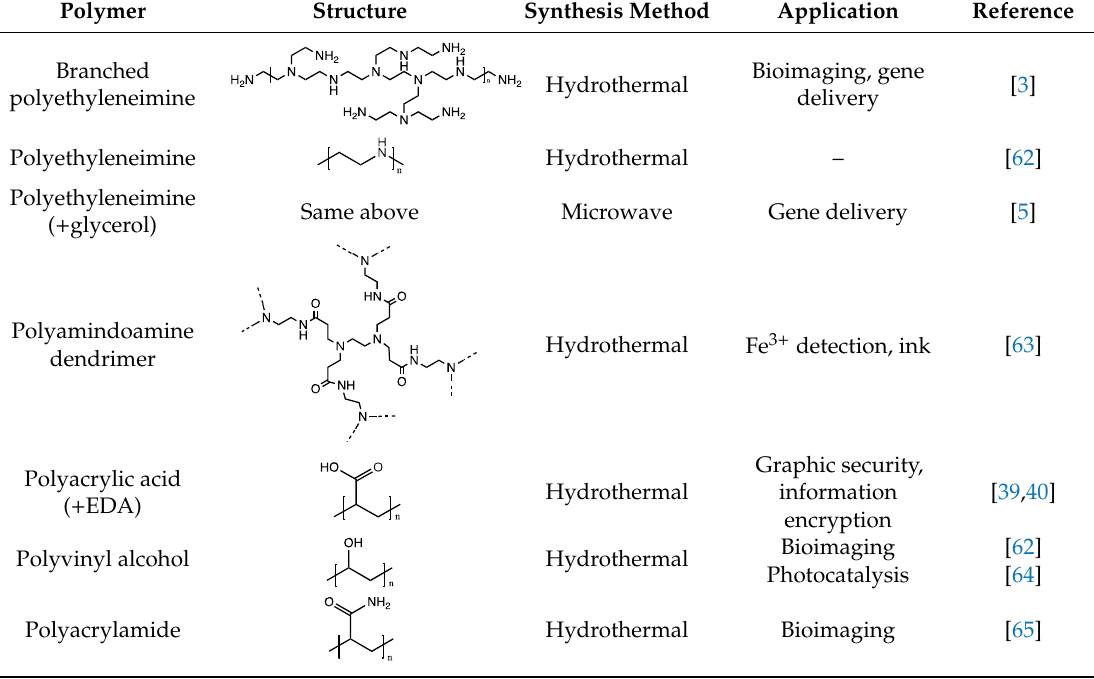
Table 4. Synthetic polymer-derived CDs, preparation methods, and applications.